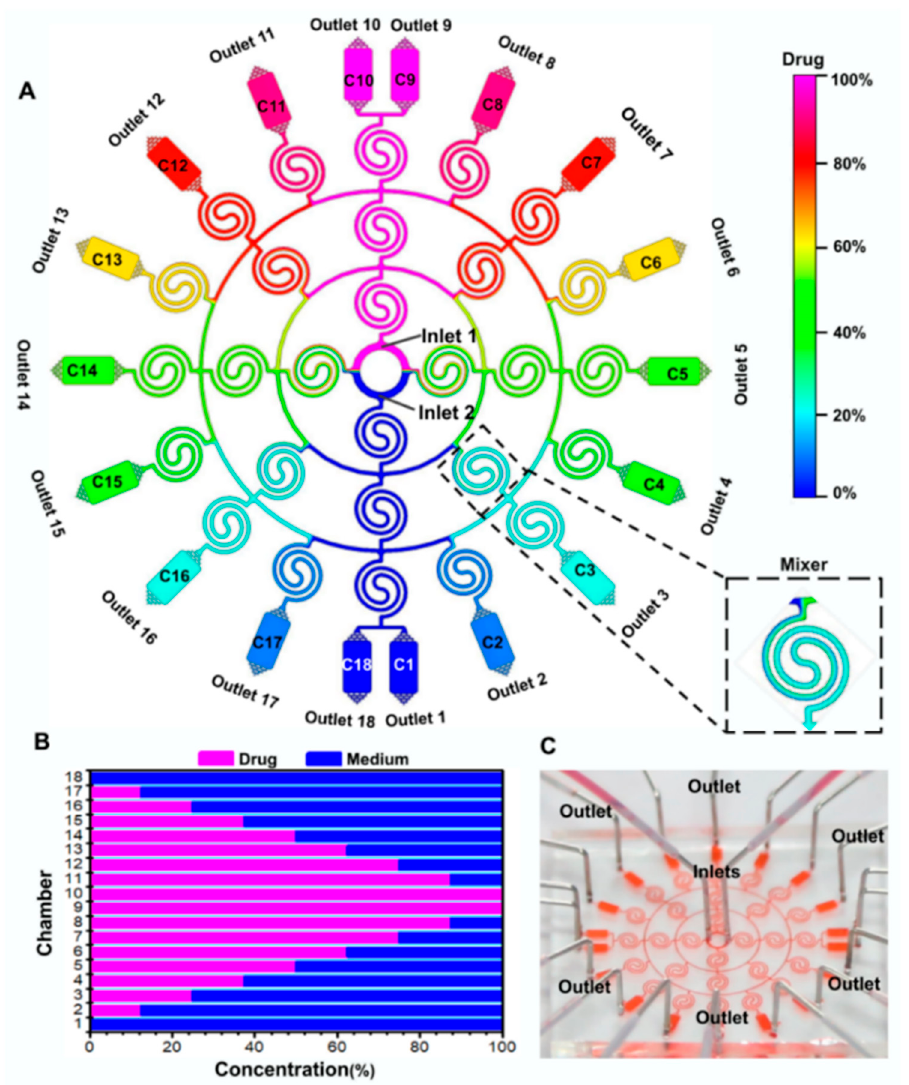
Figure 1. Schematic diagram of concentration gradient construction in the designed device under a flow rate of 20 μ L·min − 1 . ( A ) Simulation images of different concentration gradients in the device. ( B ) Quantitative characterization of the concentration gradient formed in the microchamber of each terminal of the device. ( C ) Actual microfluidic device. The food dye solution (red) is loaded in the designed microfluidic device from the inlets.